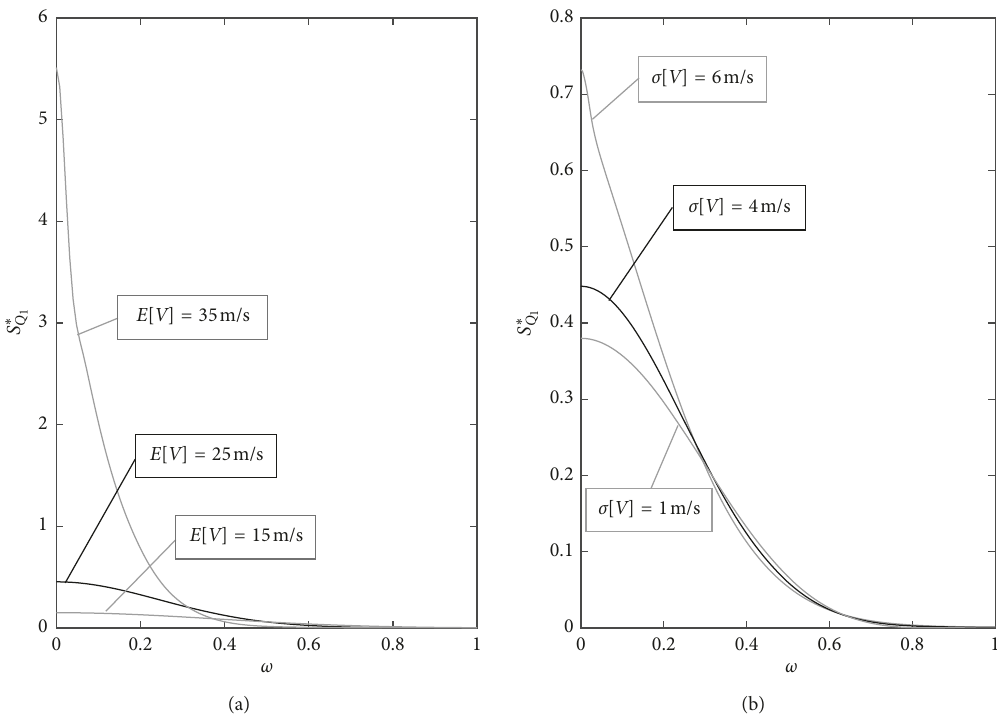
Figure 3: Scaled modal input PSD S ∗ 3 ] (equation (32)) as a function of ω (Hz) for different mean values (a) and standard deviations (b) of Q 1 [s crossing speeds V .